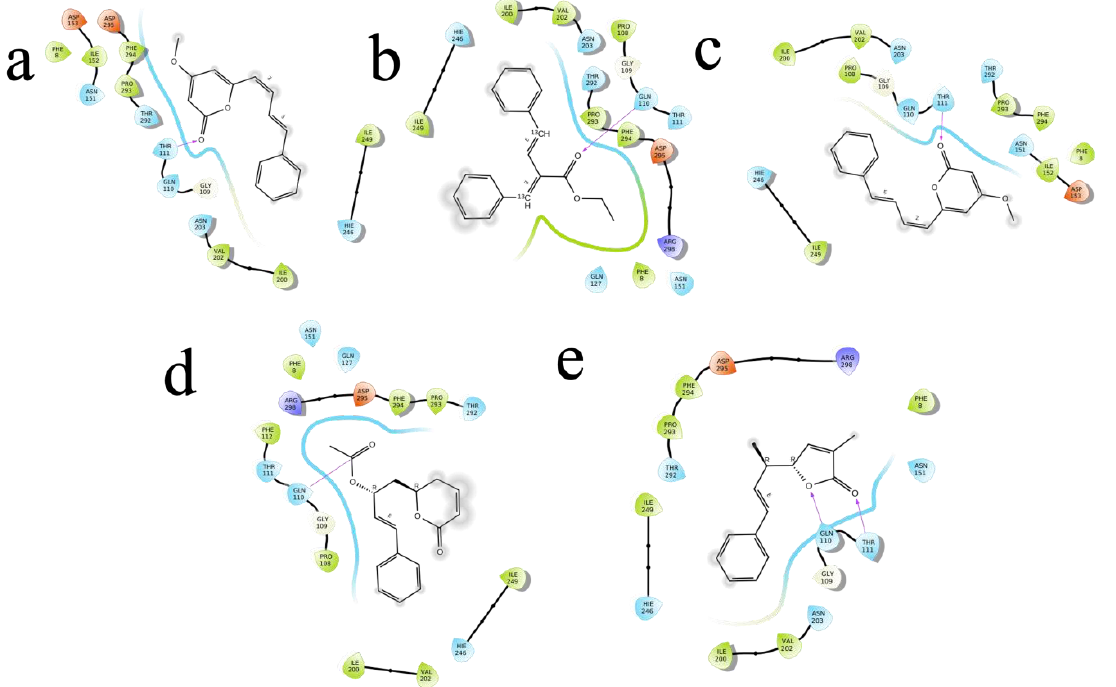
Figure 8. The 5 highest-ranked compounds with the main protease of their two-dimensional interactive diagram are represented as M1 ( a ), M2 ( b ), M3 ( c ), M4 ( d ), and M5 ( e ).